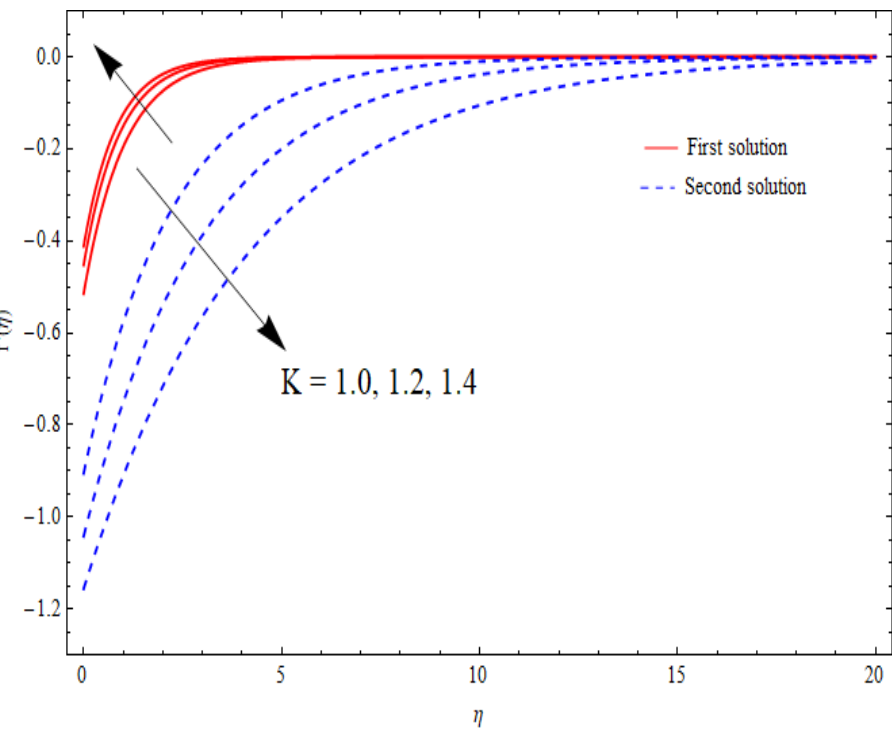
Figure 12. Velocity